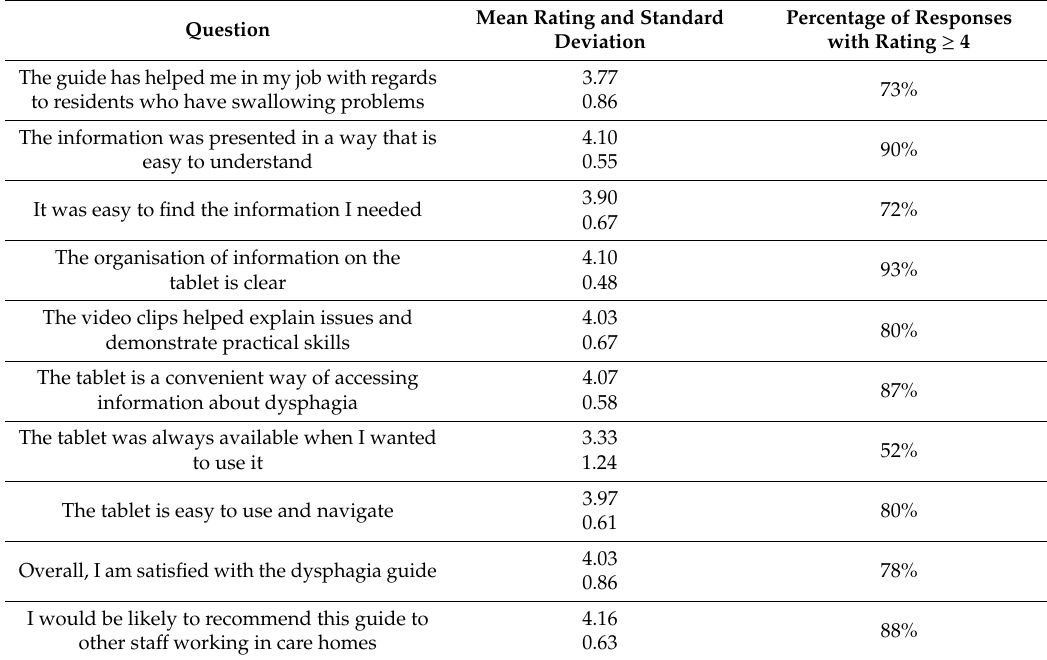
Table 2. Rating derived from 5-point Likert scale: 1: strongly disagree, 2: disagree, 3: neutral. 4: agree, and 5: strongly